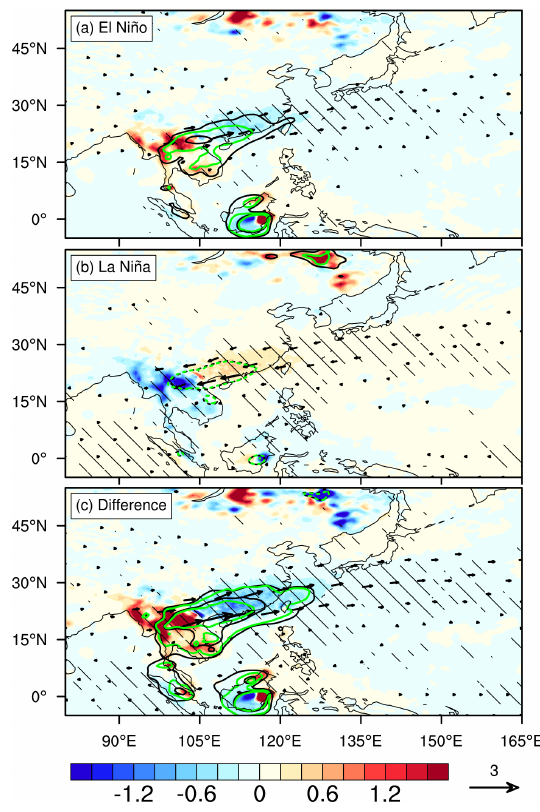
Figure 6. Composite anomalies of total AOD (black contour), AOD of carbonaceous aerosols (CAs; green contours), and CA flux (vector; 10 − 1 gm − 1 s − 1 ) as well as its divergence (shading; 10 − 7 gm − 2 s − 1 ) during (a) El Niño and (b) La Niña and (c) their difference (El Niño minus La Niña) in spring. The contour interval is 0.05; the dashed contours are for negative values, and the zero contour is omitted for clarity. Hatching and black vectors represent- ing the anomalies of CA flux and its divergence are statistically sig- nificant at the 95% confidence level based on the Student’s t test,